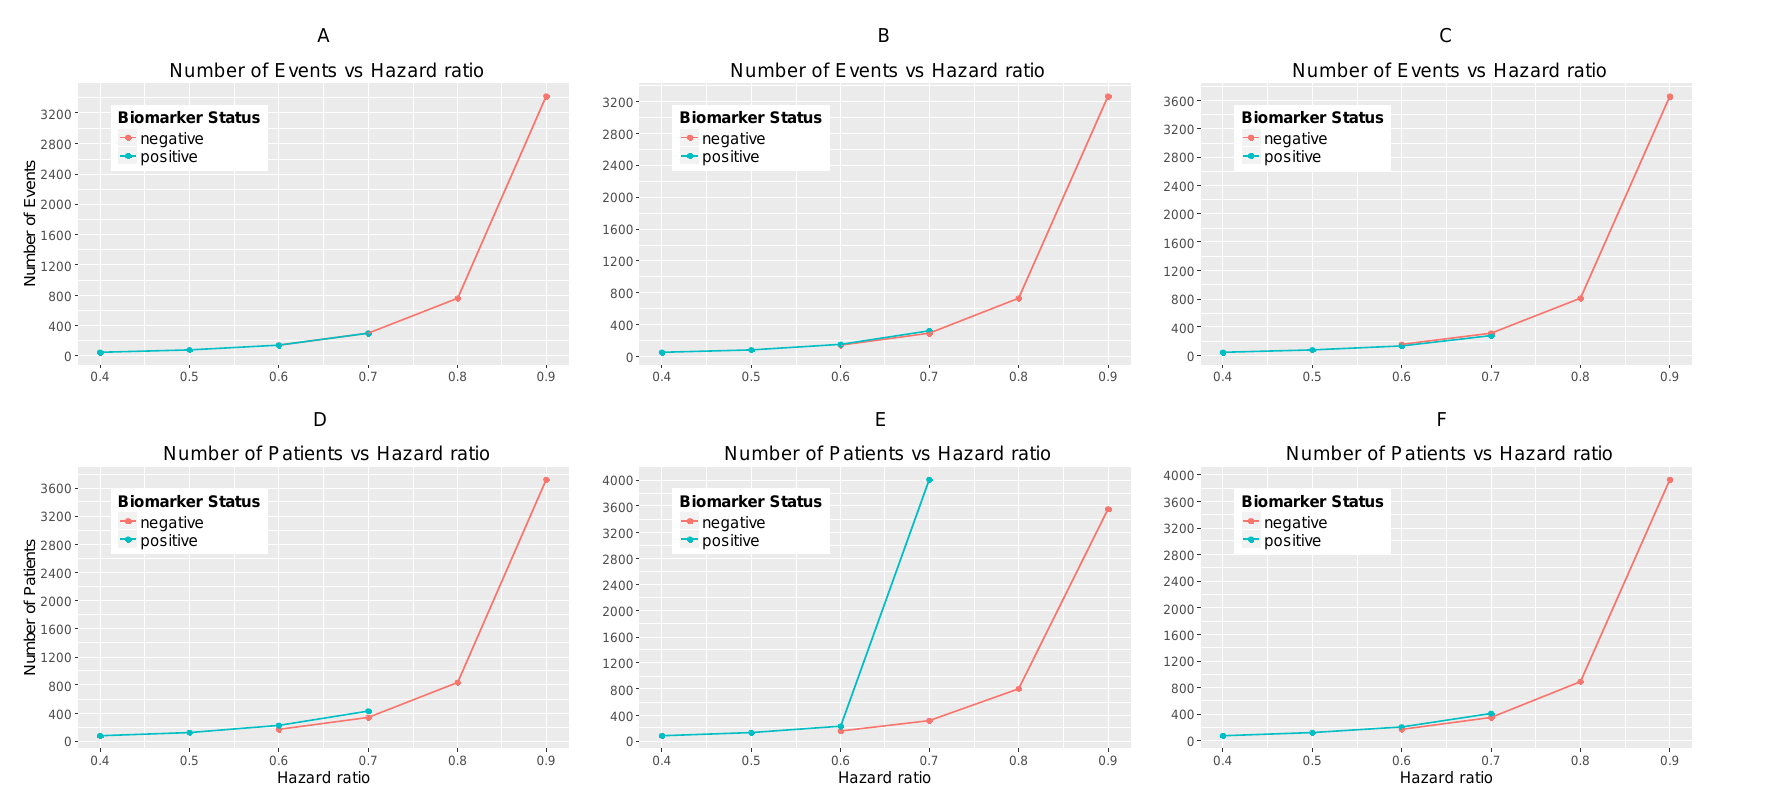
Figure 2. ( A – C ) represent the required number of events and ( D – F ) represent the required number of patients of each biomarker-defined subgroup which achieve 80% power versus the corresponding hazard ratio for each of the three scenarios of significance levels. ( A , D ) correspond to the significance levels 𝑎 − = 𝑎 + = 0.0125 , ( B , E ) correspond to the significance levels 𝑎 − = 0.015 and 𝑎 + = 0.010 and ( C , F ) correspond to the significance levels 𝑎 − = 0.010 and 𝑎 + = 0.015 .